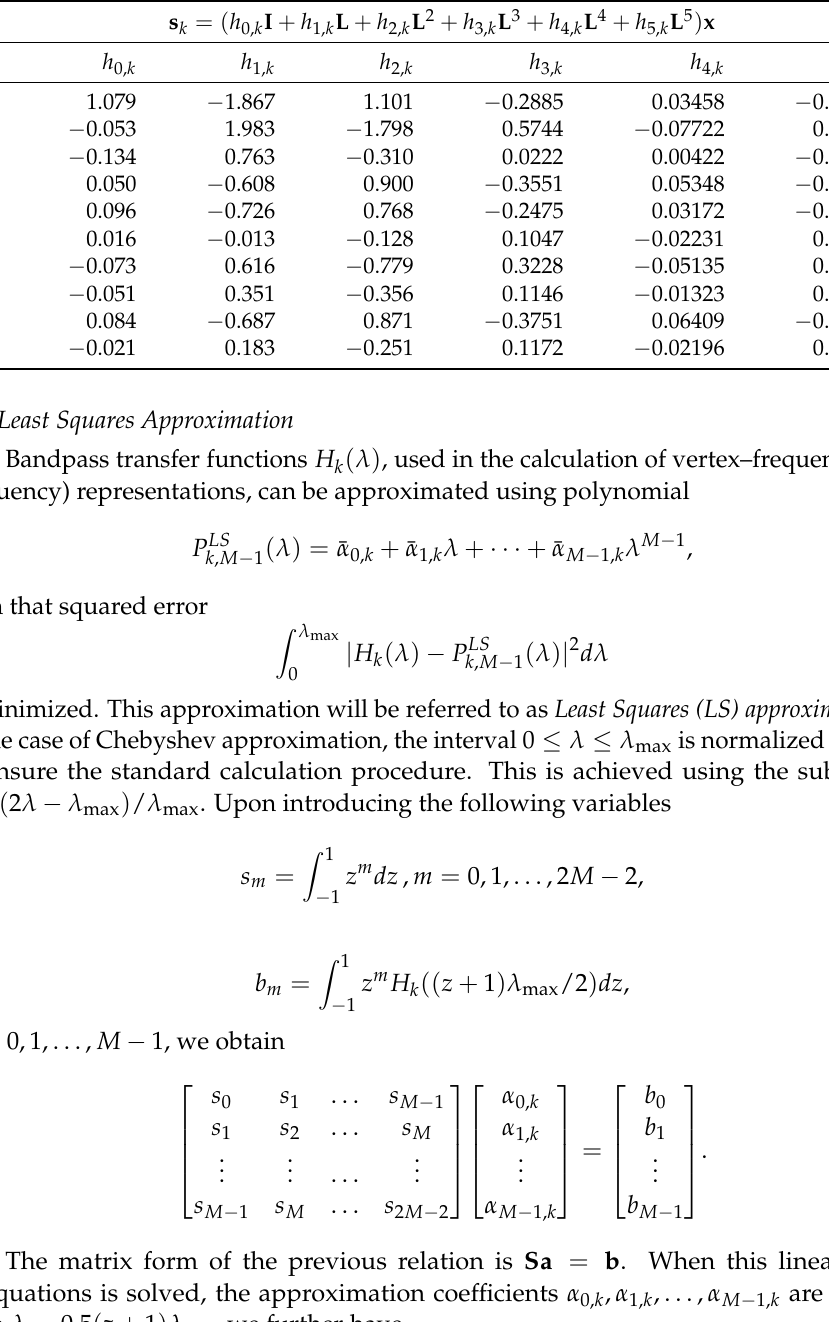
Table 1. Coefficients, h p , k , p = 0,1, . . . , M − 1, k = 0,1, . . . , K − 1, for the polynomial calculation